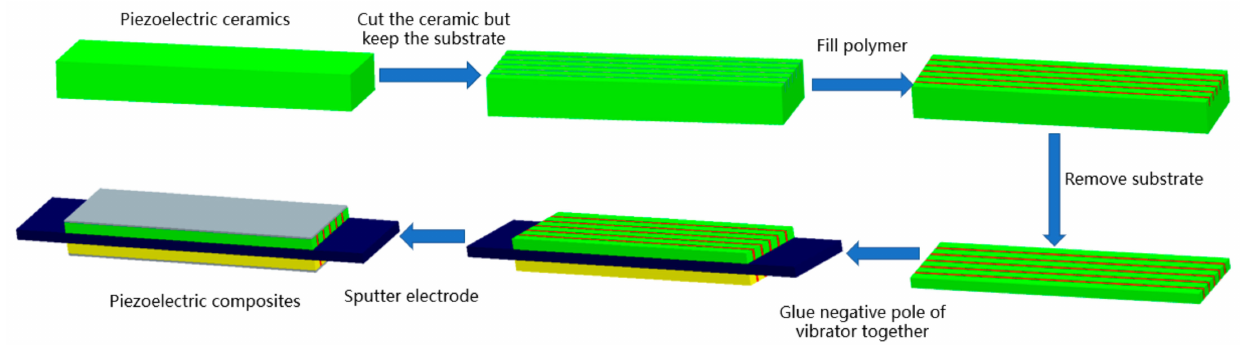
Figure 8. Flow chart of 2-2 piezoelectric composite trilaminar vibrator.